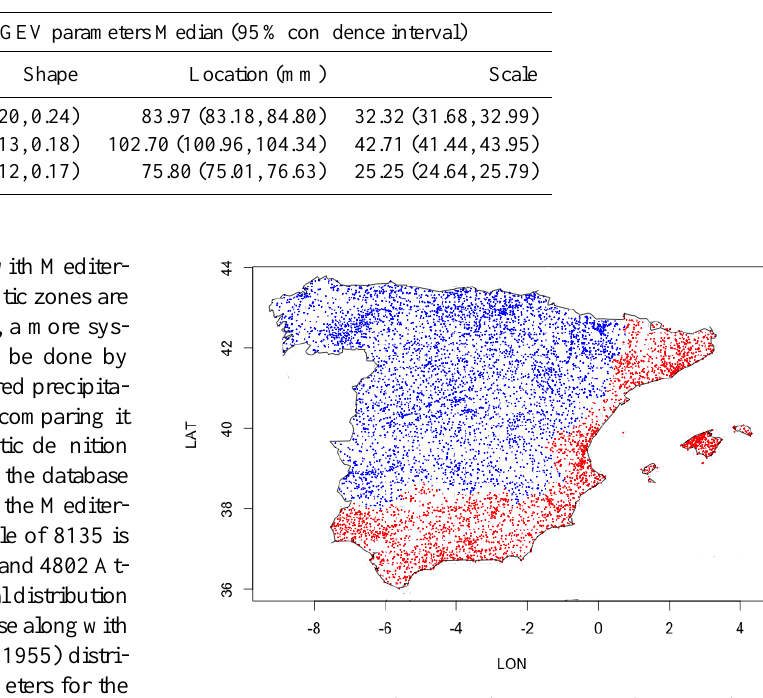
Table 3. Parameters of the three GEV distributions shown in Fig. 7b.